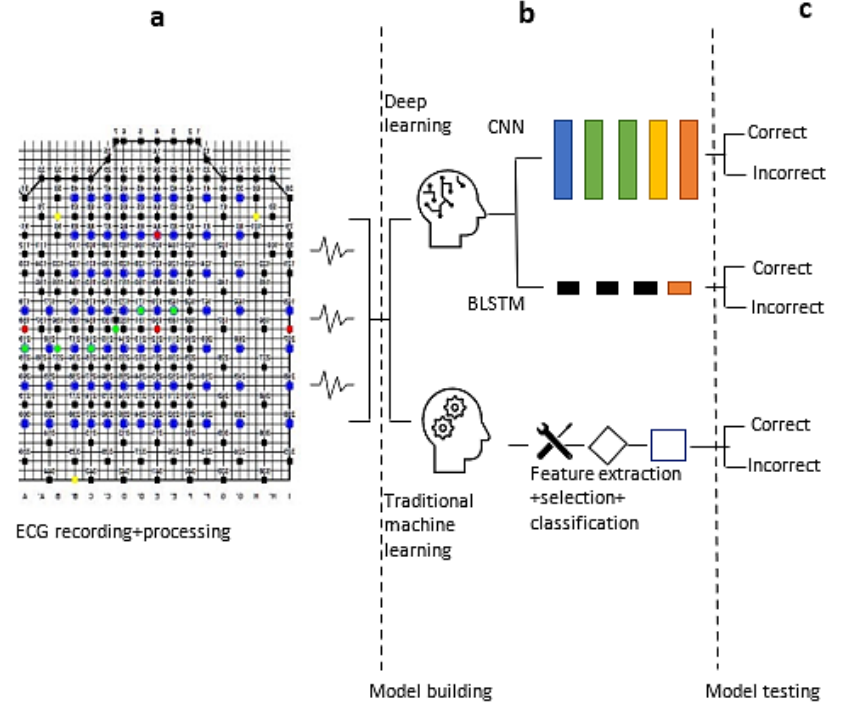
Figure 2. The data pipeline of this study using 3 phases (data engineering, analytics, and delivery). (a) The data engineering phase that includes data collection (extracting electrocardiograms from body surface potential maps) and data preparation (removing noise from extracted data). (b) The analytics phase that includes traditional machine learning (linear support vector machine, quadratic support vector machine, fine decision tree, coarse decision tree, logistic regression, and bagged tree) and deep learning (convolutional neural network and bidirectional long short-term memory network). (c) The delivery phase that is used to show traditional machine learning and deep learning model inferences. BLSTM: bidirectional long short-term memory; CNN: convolutional neural network; ECG: